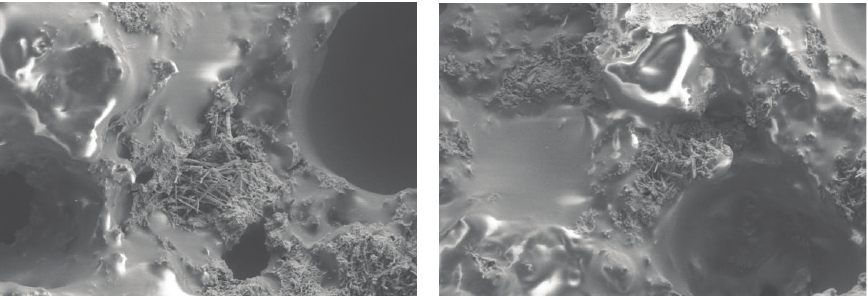
Figure 10: Microstructure of cement-asphalt mix.